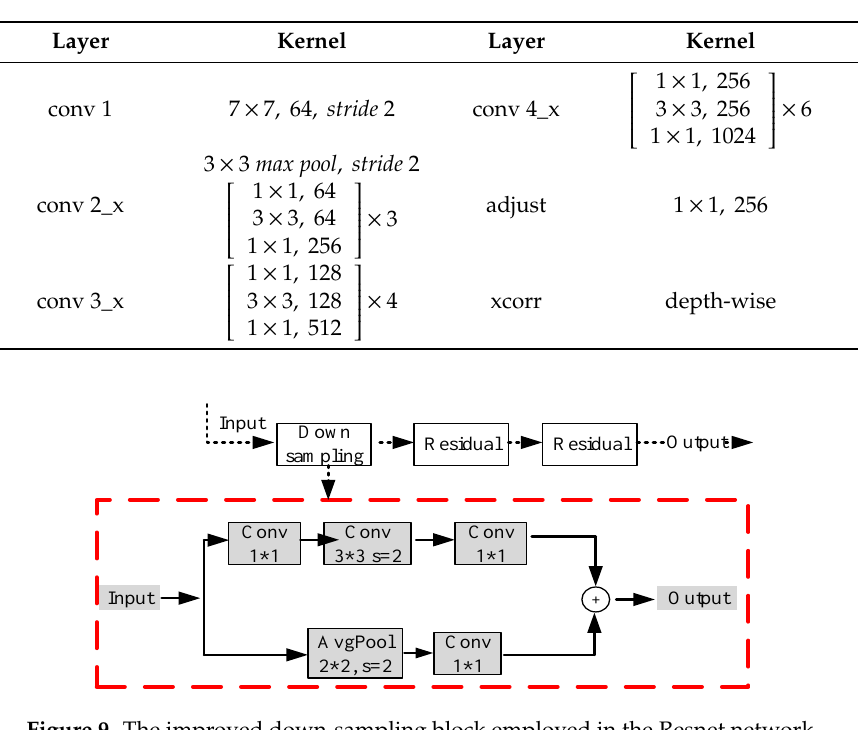
Figure 8. Gray distribution of the contact wires during different motions presented in Figure 4. ( a ) Contact wire images obtained from the laboratory test. ( b ) Contact wire images obtained under strong sunlight. ( c ) Contact wire images obtained under poor sunlight. Table 1. Backbone for Resnet_50.